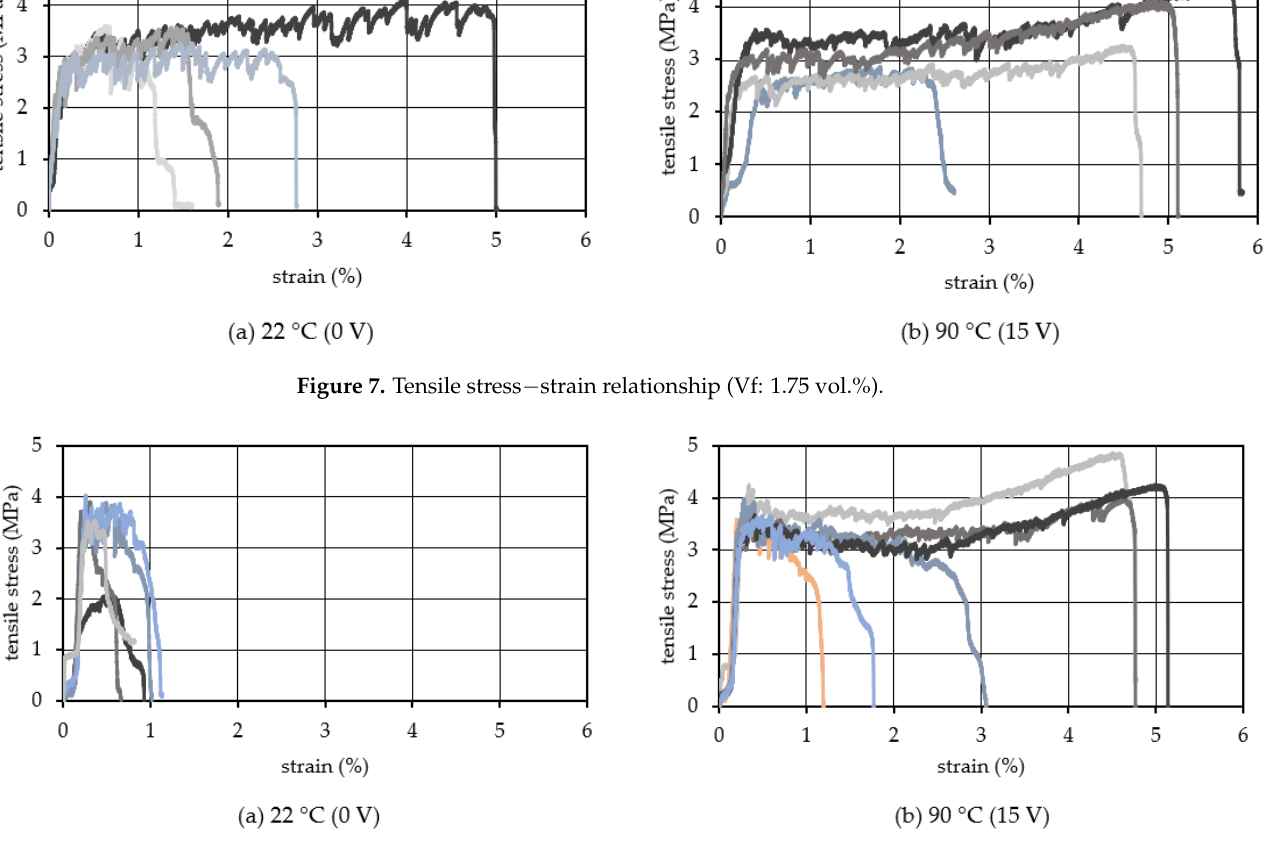
Figure 8. Tensile stress − strain relationship (Vf: 2.00 vol.%).